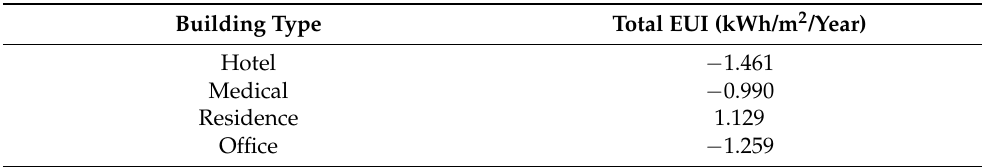
Table 5. The changes in EUI under the climate